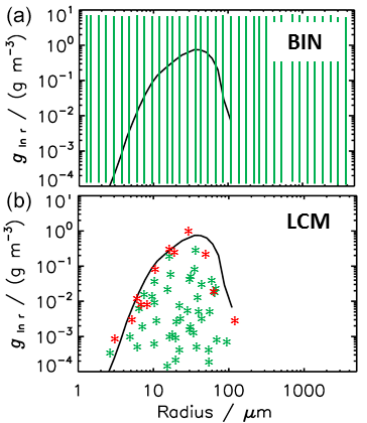
Figure 1. Schematic plot of how a droplet size distribution is discre- tised in a bin model and represented by a SIP (simulation particle) ensemble in a Lagrangian cloud model (LCM). The red and green stars shows two different realisations of a SIP